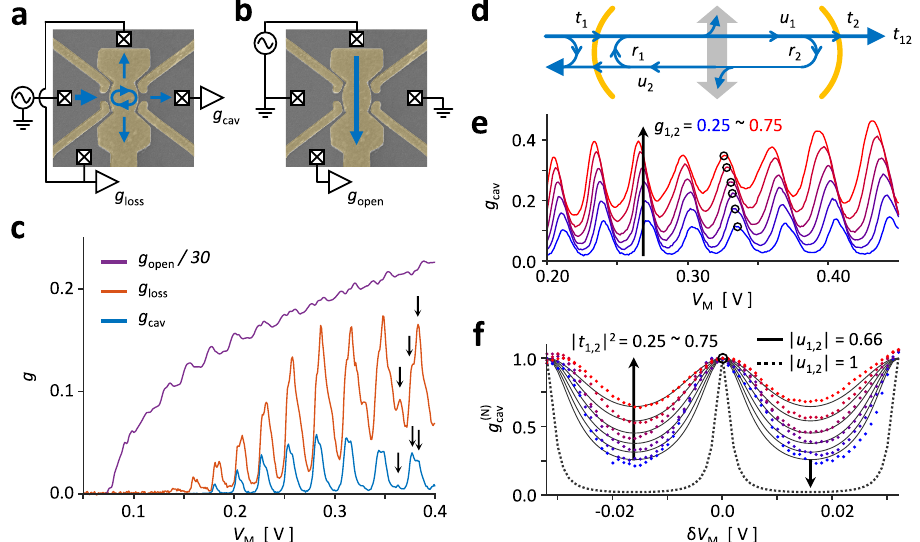
Fig.2|Opencavitymodes.a Transmissionpropertiesofthecavityresonatorwere measuredbythe conductances g cav and g loss . b Openness of the cavity region was given by g open which measures the transmission in the direction transverse to the cavity (blue arrow). c Cavity transmissions g cav and g loss measured against V M showscoincidingresonancepeaks,implyingthepresenceofcirculatingwaves,i.e., cavity modes. The longitudinal nature of the modes can be seen by the quasiper- iodicity of the conductance peaks, and hints of the transverse modes can be seen bythe fi nepeakstructures(arrows).Thesecharacteristicswereobservedwhilethe cavity stayedhighly open to its sides, asseen from g open . d The mesoscopic cavity